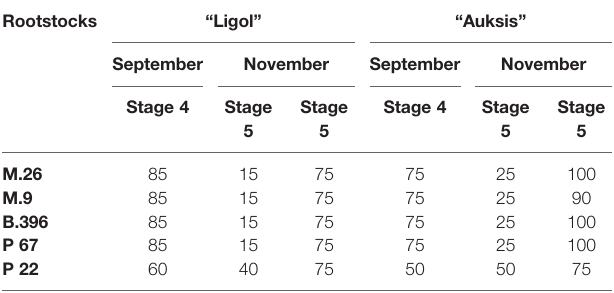
TABLE 2 | Bud development (%) of “ Ligol ” and “ Auksis ” apple trees in autumn.